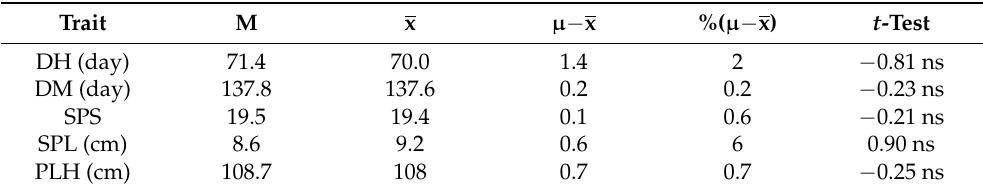
Table 4. Comparisons of the mean values of the top 5% genotypes (x) with the mean value of the 420 genotypes ( µ ) for the nine quantitative